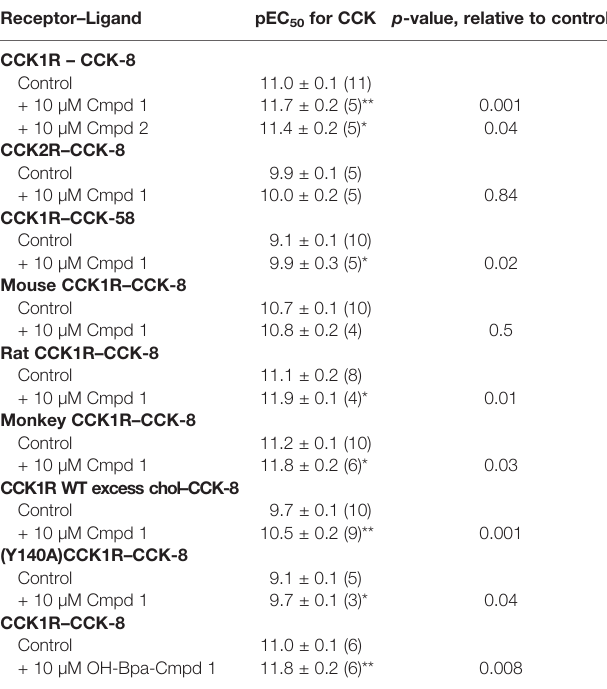
Data represent means ± S.E.M. of duplicate determinations in “ n ” independent experiments (numbers displayed in parentheses). Differences between control and the presence of small-molecule compounds were evaluated using the Mann – Whitney test. *p < 0.05; **p <